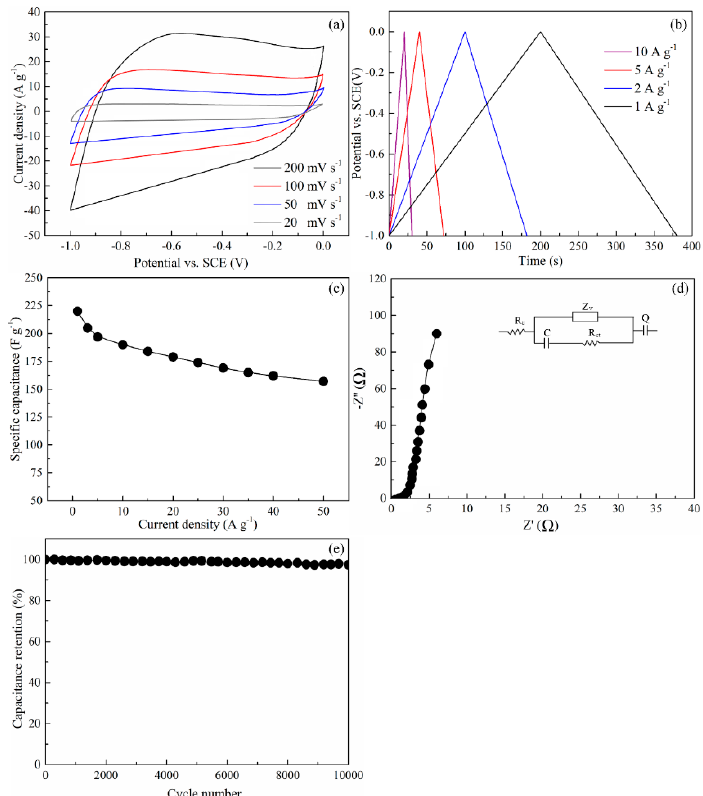
Figure 7. Electrochemical performances of AC-2FeHLH-5-41.4(H) in 6 M KOH electrolyte: ( a ) cyclic voltammetry curves of AC-2FeHLH-5-41.4(H) at the scan rates of 20 to 200 mV s − 1 ; ( b ) galvanostatic charge-discharge curves of AC-2FeHLH-5-41.4(H) at di ff erent current densities; ( c ) gravimetric capacitances of AC-2FeHLH-5-41.4(H) at di ff erent current densities; ( d ) Nyquist plots of AC-2FeHLH-5-41.4(H) inset shows the fitting equivalent circuit model; and ( e ) cycling stability of AC-2FeHLH-5-41.4(H) at a current density of 5 A g − 1